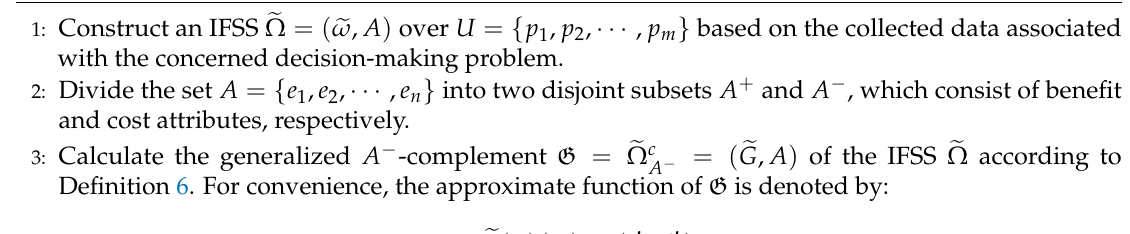
Algorithm 1 The algorithm for intuitionistic fuzzy